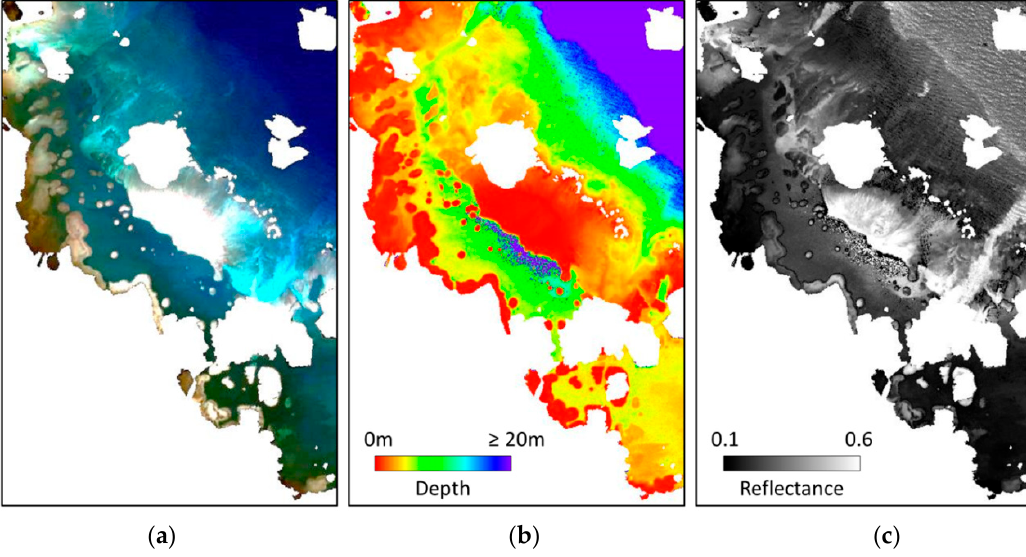
Figure 2. Inversion model output for 2000 Kaneohe Bay AVIRIS-C data at 18 m spatial resolution: ( a ) True-color image; ( b ) derived water depth; and ( c ) derived benthic reflectance at 550 nm. Masked areas of land, cloud, cloud shadow, and wave breaks are shown in white.